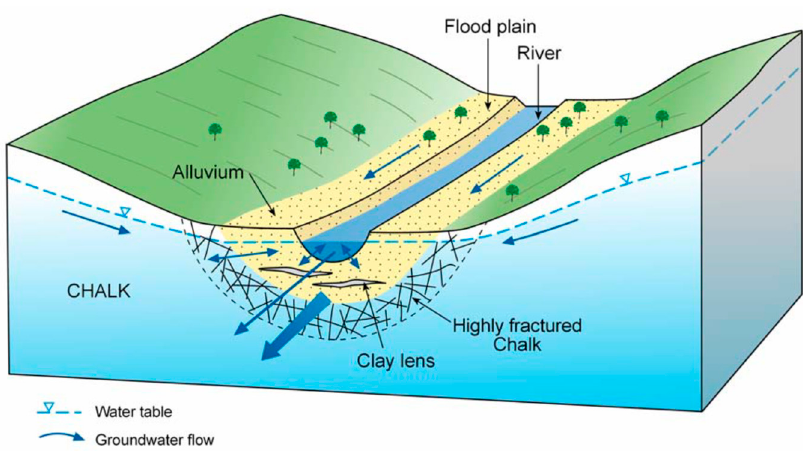
Figure 14. Wetland biogeochemical cycling hotspots: their role in lowland permeable catchment hydrochemical function. Figure provided by British Geological Survey.